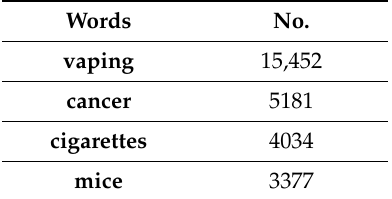
Table 1. Most frequently occurring